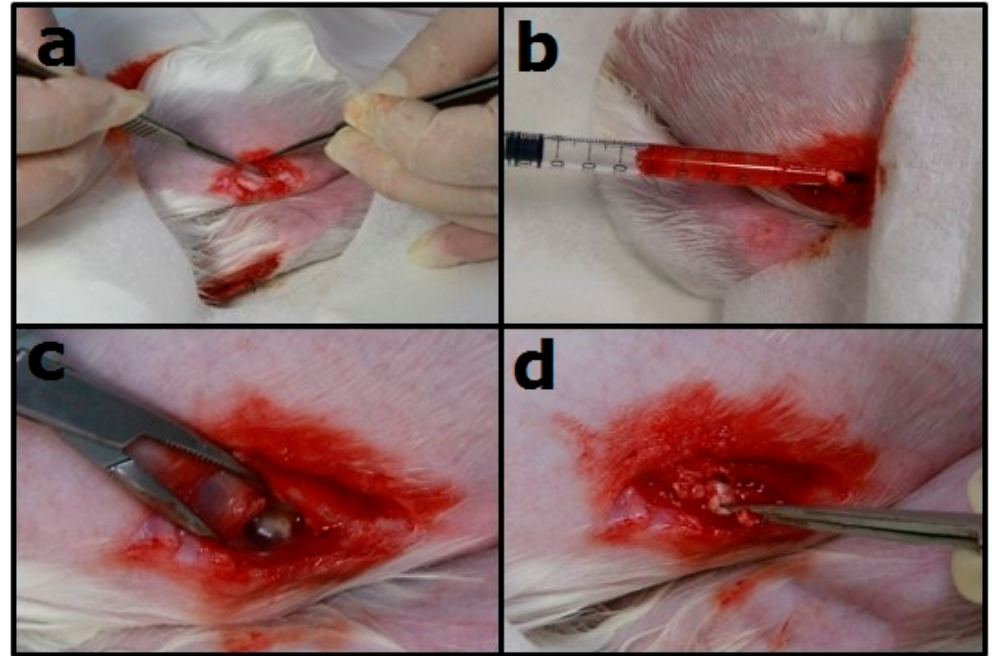
Figure 3. Sampling the specimen from the knee joint of New Zealand white rabbits. ( a ) The knee joint of the rabbit was opened; ( b ) the synovial fluid was sampled using a syringe; ( c ) the wound was opened; ( d ) the residual drug-eluting nano/microparticles could be seen.